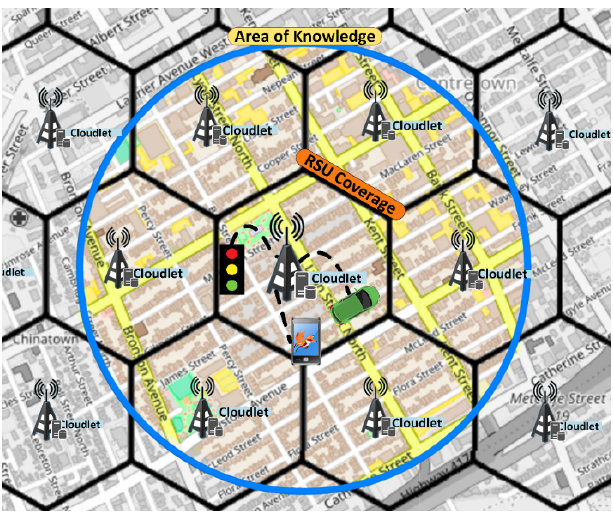
Figure 4. Cloudlet